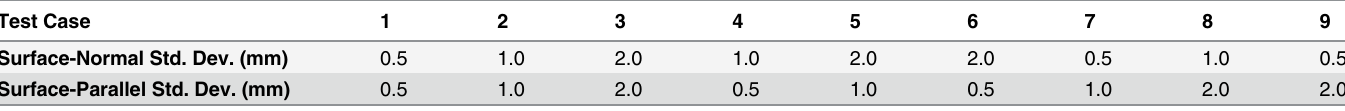
This table de fi nes the standard deviation of noise generated in the surface-normal and surface-parallel directions for each point of the source shapes in Experiments 2 –